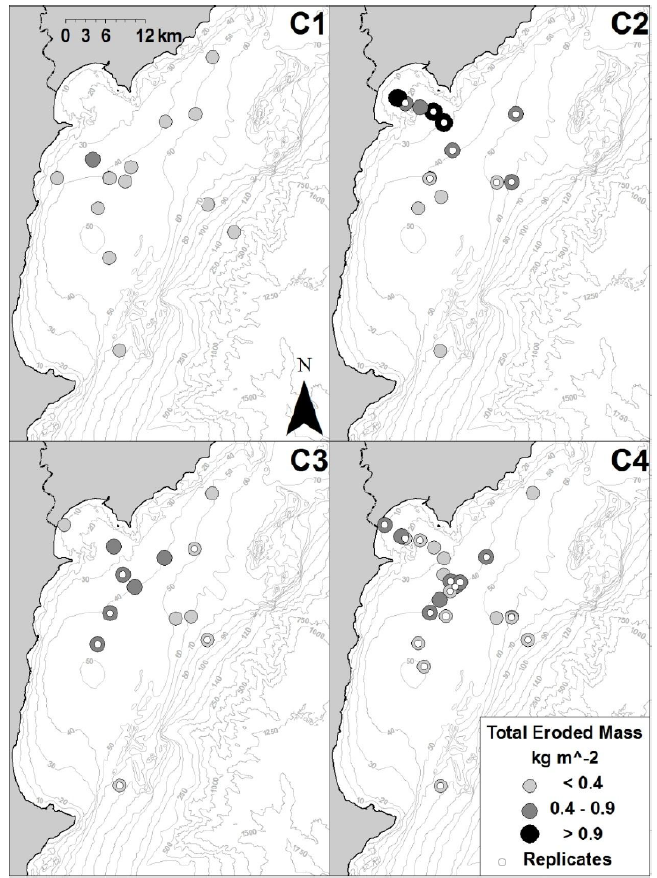
Figure 10. Observations of eroded mass from [36] for Gust microcosm erodibility experiments from January 2010 ( C1 ), May 2010 ( C2 ), September 2010 ( C3 ), and February 2011 ( C4 ). Grey bathymetric contours are every 10 m until 100 m water depth. Figure reproduced with permission from [36], copyright © Kiker, 2014.